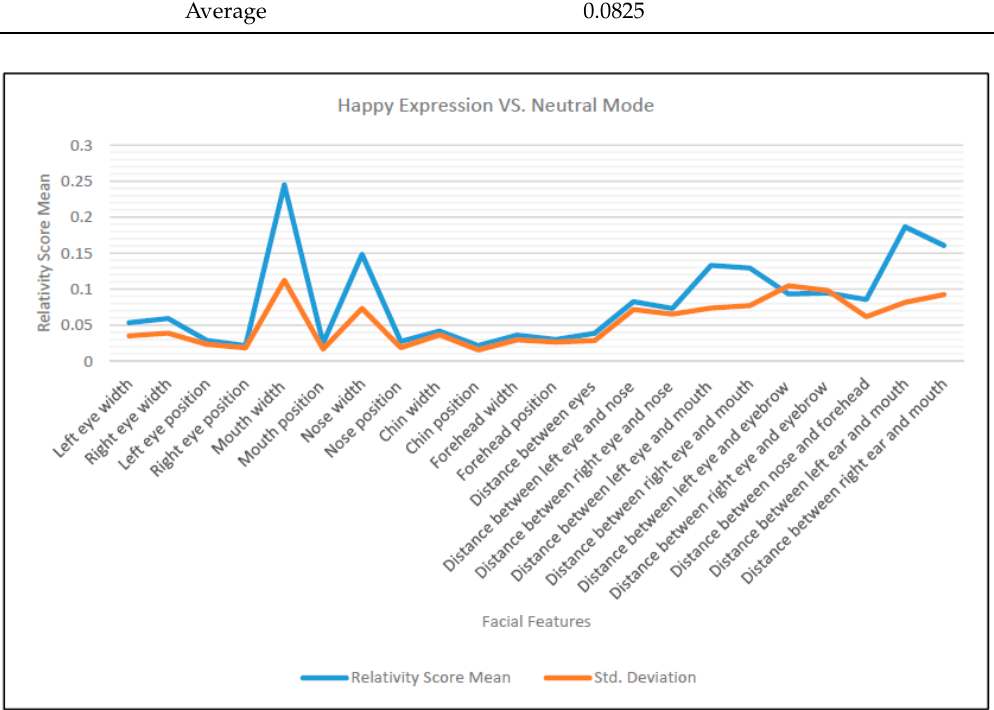
Figure 14. The means of RSS between happy expression and neutral mode of facial features for 36 subjects.